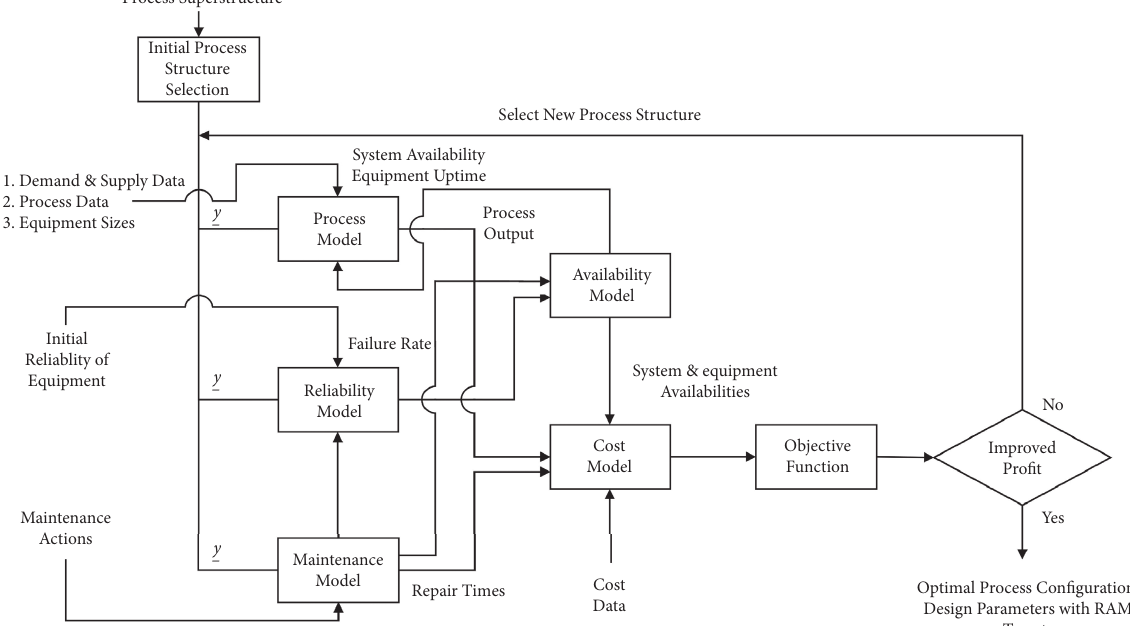
Figure 3: Models interactions: joint integrated process synthesis and availability optimization